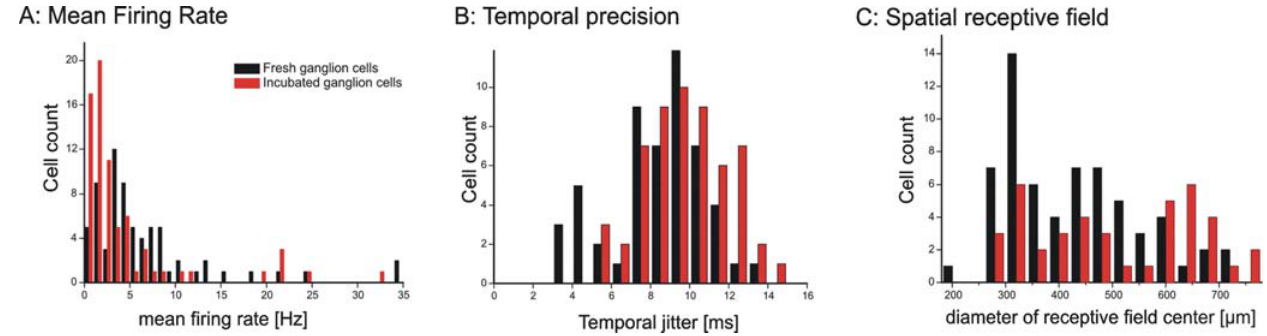
Figure 4. Electrophysiological properties of ganglion cells in incubated retinas are comparable to properties of freshly prepared ganglion cells . (A) Histogram of average firing rates for 69 ganglion cells from 5 retinas after 2 days (3 retinas) or 3 days (2 retinas) of incubation (red columns) and 73 ganglion cells from freshly prepared retinas (black columns). All cells were recorded with multielectrode arrays; the firing rate was calculated in response to spatial white noise (see Methods). The two distributions are similar, although more incubated cells are recorded with mean firing rates below 2 Hz. (B) Histogram of temporal jitter in response to the same spatially uniform temporal white noise stimulus. The temporal jitter distribution does not differ significantly (p , 0.05, ANOVA) for the two populations. Mean temporal jitter was 10 milliseconds for incubated ganglion cells and 8.6 milliseconds for fresh ganglion cells. (C) The diameters of receptive field centers. Mean receptive field center was 520 m m for incubated ganglion cells (n=43) and 430 m m for fresh ganglion cells (n=73).